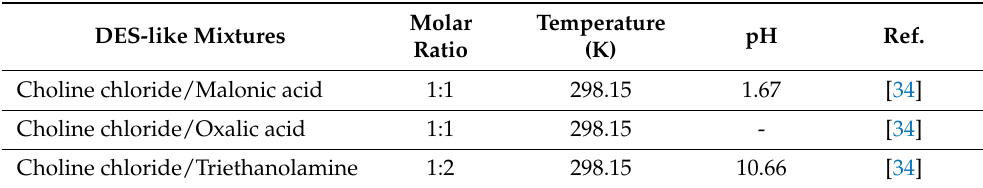
Table 9. pH data of DES-like mixtures at different temperatures (adapted according to Bahadori et al. [34]., Jibril et al. [35], Mjalli et al. [36]). DES-like